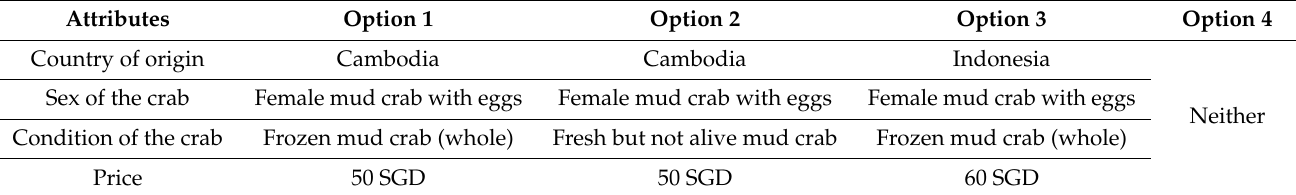
Table 2. An example of choice sets from the Discrete Choice Experiment